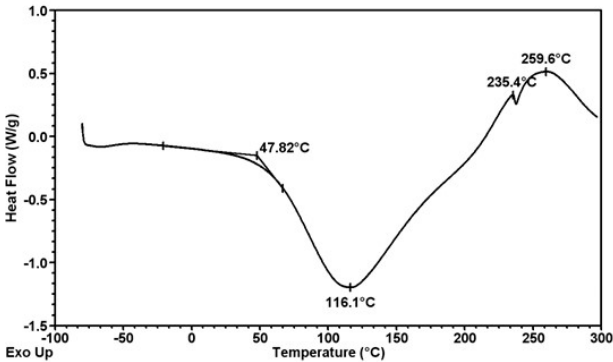
Figure 9. Thermogram of calcium alginate fiber with 2% nano Zn.